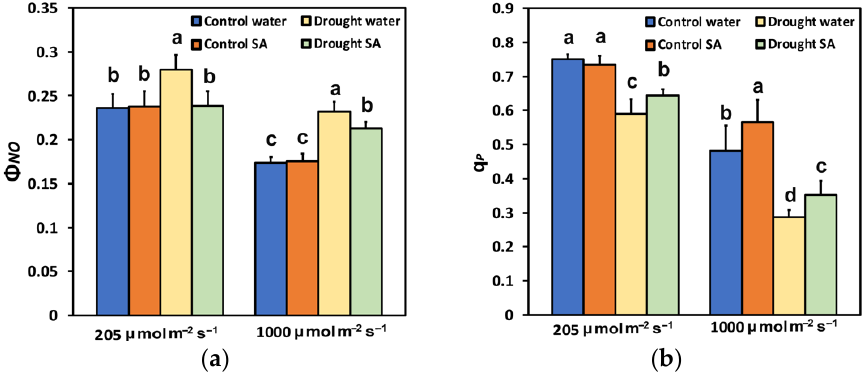
Figure 3. The quantum yield of non-regulated energy loss ( Φ NO ) ( a ); and fraction of open PSII reaction centers (q p ) ( b ); of oregano seedlings grown under optimal conditions (control) or moderate drought stress (MoDS), and sprayed by 1 mM SA or H 2 O. Φ NO and q p were estimated at 205 (LL) or 1000 (HL) μ mol photons m –2 s –1 actinic light (AL) intensity. Error bars represent standard deviations ( n = 4). Different lowercase letters, within the same light treatment, represent statistical difference ( p < 0.05).